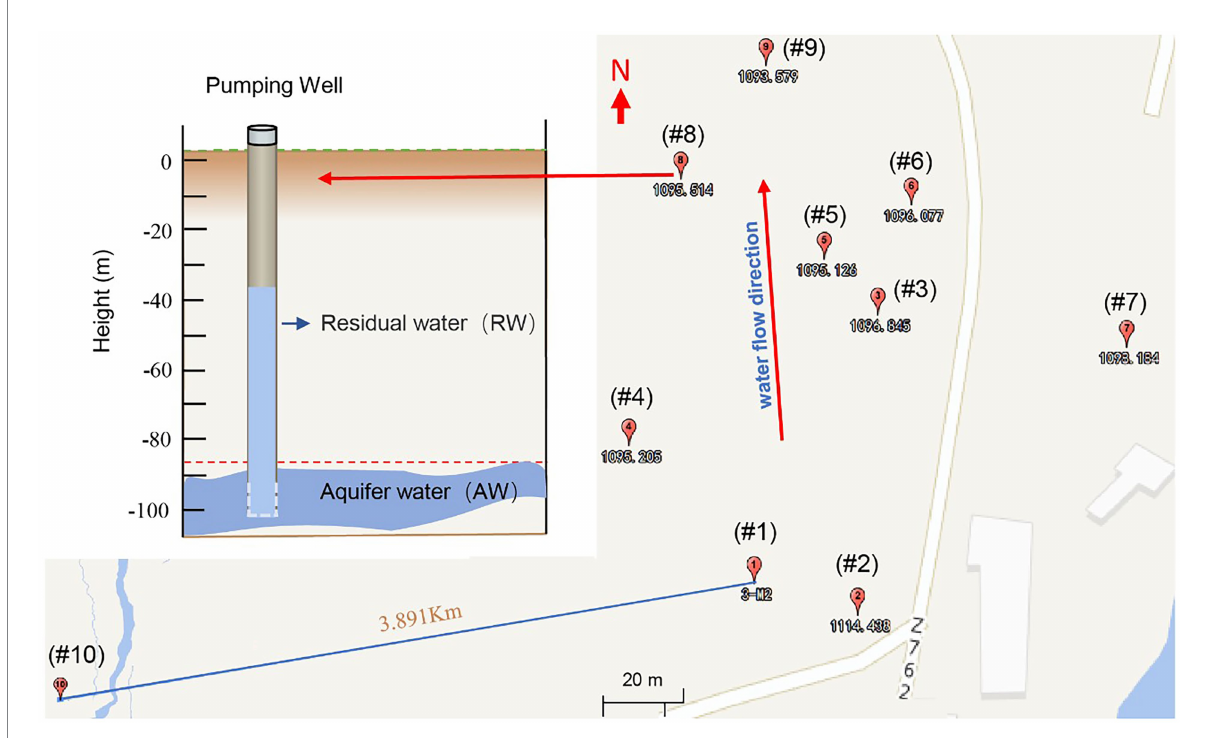
FIGURE 1 Groundwater sampling locations of a uranium mining area in the southern margin of the Ili Basin, Xinjiang in China. Sampling well number from #1 to #9 (the subscript number is the standard height in meters, where each well has two sampling points, namely the Residual Water (RW) and the Aquifer water (AW) (See the upper left). The RW sample is the groundwater originally left in the hole, while AW refers to the aquifer water after pumping twice the volume of water in the pipe. In addition, we also took a sample for the background value (#10), which represented the natural state of the study area before mining, located on the periphery of the mining